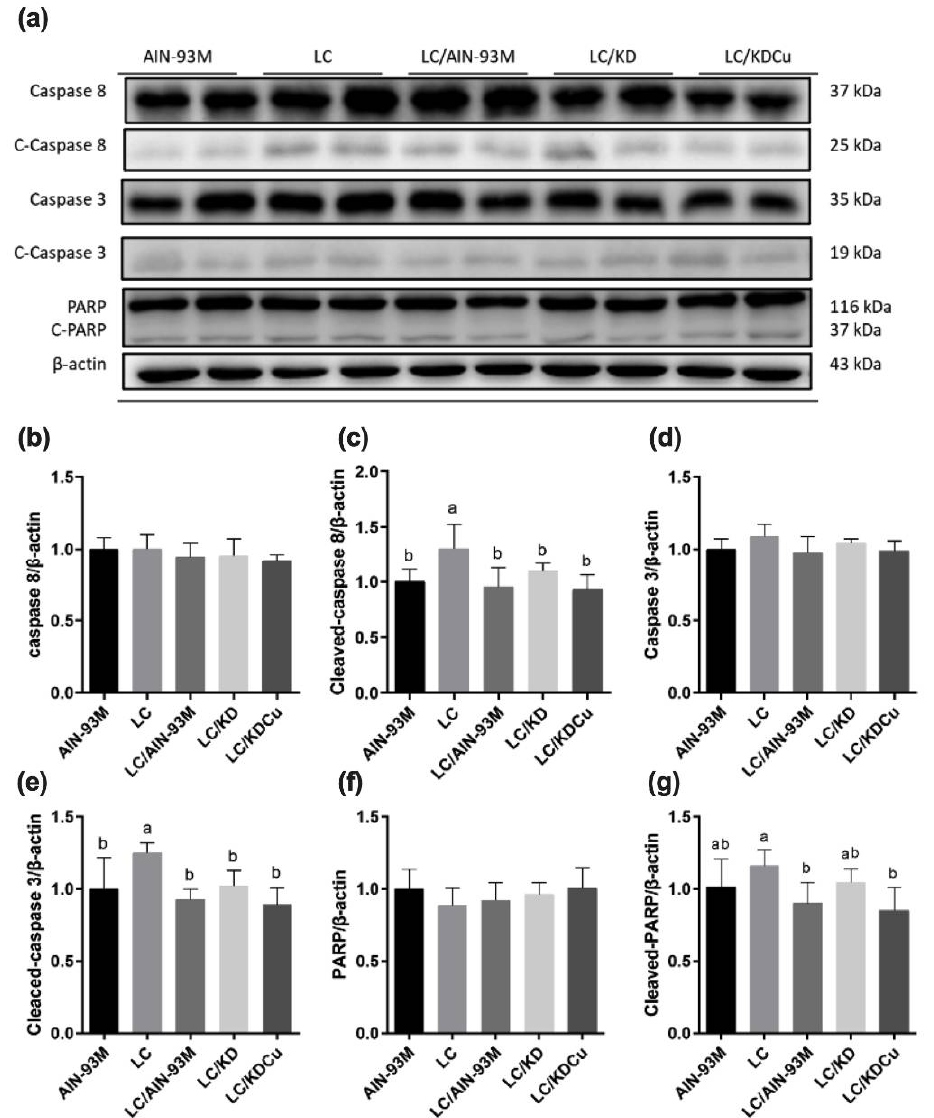
Figure 9. Effects of the low carbohydrate diet and curcumin on testicular extrinsic apoptosis pathway regulators ( a ) protein expressions in each group, ( b ) caspase 8, ( c ) cleaved-caspase 8 ( d ) caspase 3 ( e ) cleaved-caspase 3, ( f ) PARP, ( g ) cleaved-PARP in male mice. Data are expressed as means ± SD. n = 6–9 per group. Bars (a, b) with different letters indicate that values are significantly different. (One-way ANOVA, Duncan’s test, p < 0.05). AIN-93M: AIN-93M diet; LC: low carbohydrate diet; LC/AIN-93M: low carbohydrate diet changed to AIN-93M diet; LC/KD: low carbohydrate diet changed to ketogenic diet; LC/KDCu: low carbohydrate diet changed to ketogenic diet and curcumin.